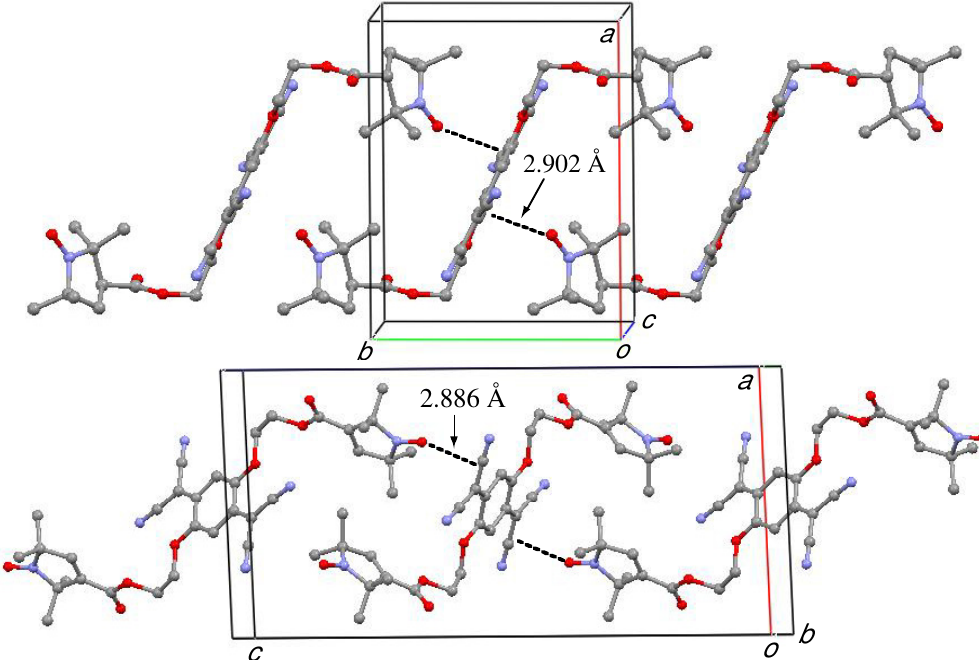
Figure 2. Crystal structure of 3b ( upper ) and 3c ( lower ) . Three molecules are depicted and the broken lines indicate short intermolecular contacts. Hydrogen atoms are omitted for clarity and the ORTEP figures with hydrogen atoms are included in